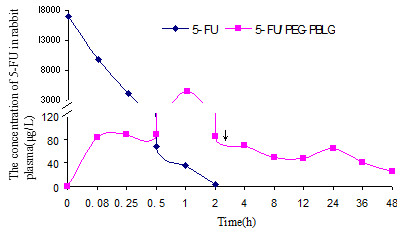
Mean plasma concentration of 5-FU following a single i.v. administration of 5-FU or 5-FU/PEG-PBLG nanoparticles at 30 mg/kg. The arrow depicts sustained release.